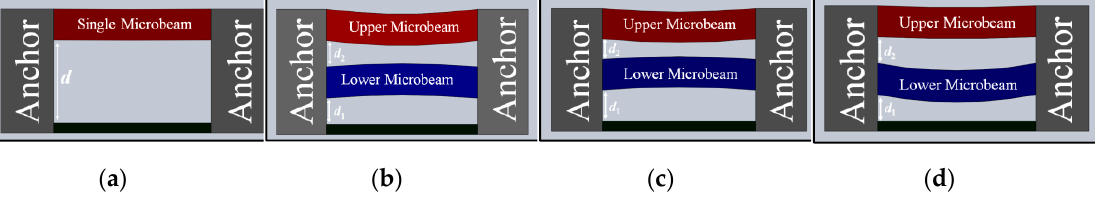
Figure 7. Comparison between the static profiles of ( a ) the single-microbeam configuration at V DC = 23 Volt with the double microbeam configuration just before the pull-in voltage for the case of: ( b ) d 1 = d 2 ; ( c ) d 1 > d 2 ; ( d ) d 1 < d 2 (Note: the length (L) in the above sketches is not to the scale).